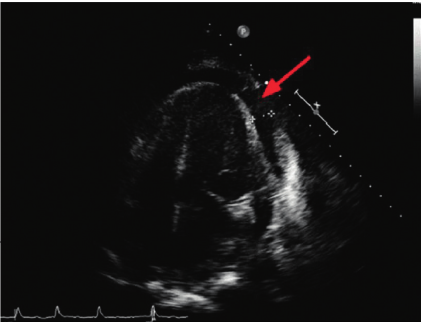
Figure 1: Transthoracic echocardiogram (TTE) demonstrating a large pericardial effusion (red